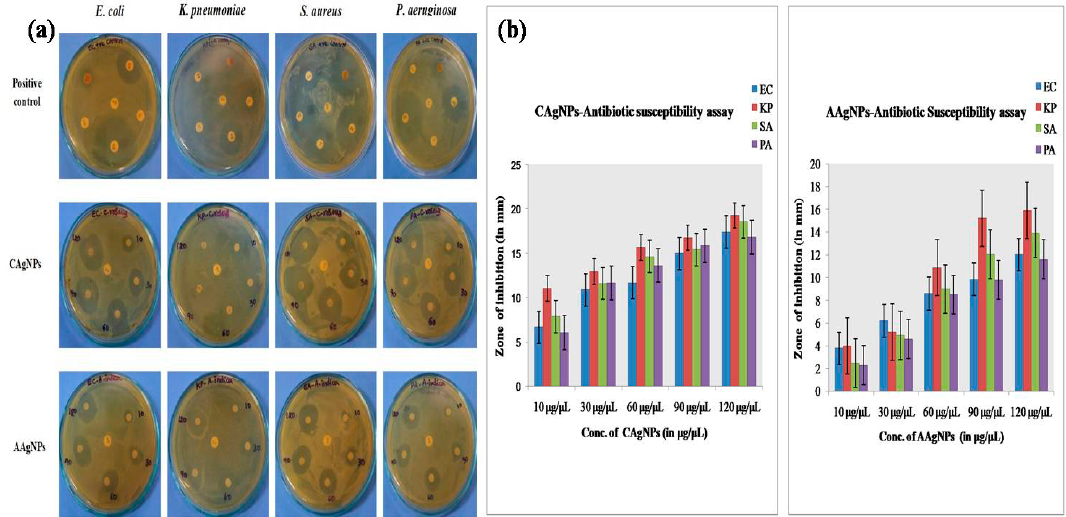
Figure 7. ( a )Antibiotic susceptibility activity of biosynthesized silver nanoparticles (C Ag NPs and A Ag NPs) demonstrated by the disc diffusion method in multidrug-resistant (MDR) bacteria. ( b ) Graphical representation of antibiotic susceptibility activity of green-synthesized Ag NPs. EC— Escherichia coli ,